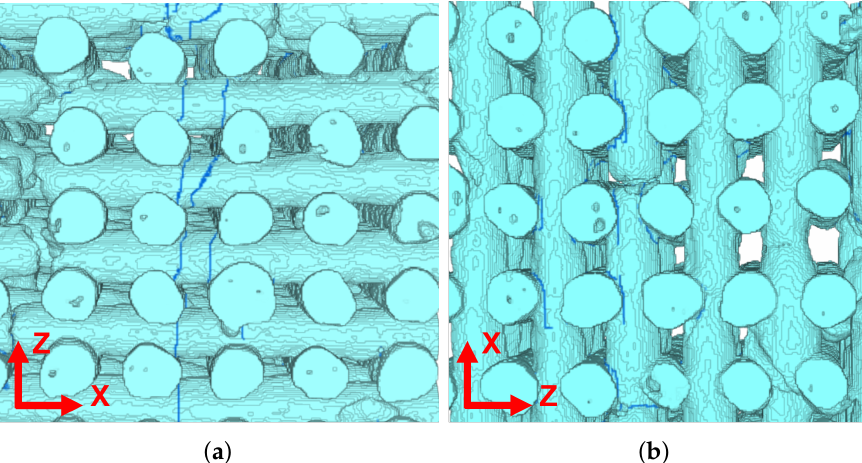
Figure 5. Crack pattern upon compressive load: ( a ) the load is orthogonal to both families of fibers and ( b ) the load is directed along the